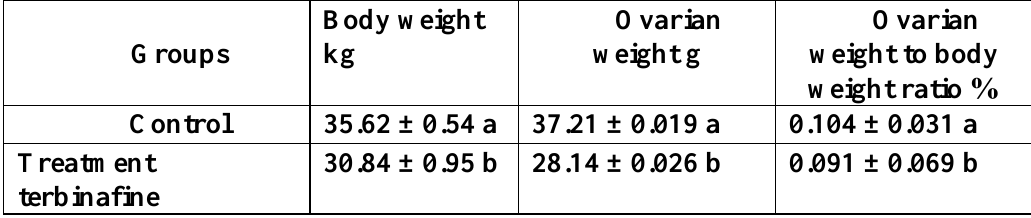
Table (4) effect of terbinafine on body weight and ovarian weigh to body